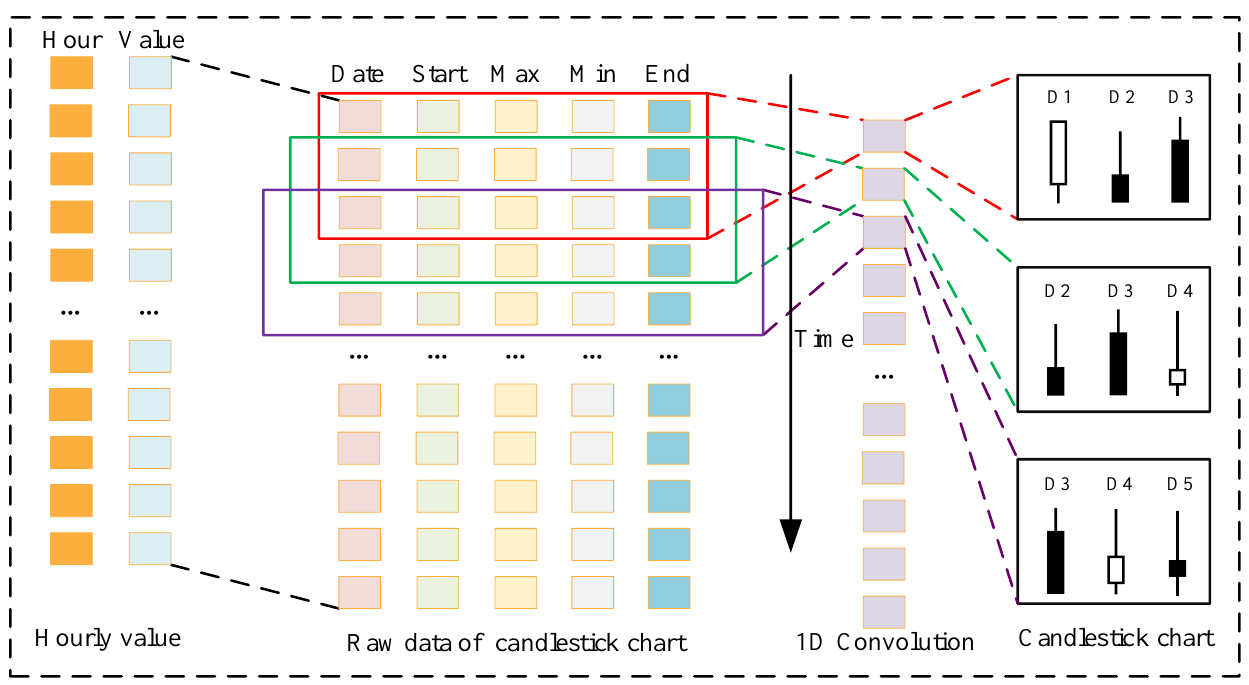
Figure 3. Principle of the candlestick chart generator. The VGG network model, proposed by the Oxford Visual Geometry Group, is adapted from the CNN mode, which can be widely used to extract image features and save key information [35]. The characteristics of the candlestick chart extracted by VGG are shown in Figure 4. The local features of water pollution were extracted by the convolutional layer, which corresponded to the pollution transfer process. The pollution on the first day would affect the pollution on the second and third days, and such features were extracted by the convolutional layer. The extracted feature was further strengthened by the pooling layer, where only strong features were retained and weak features were discarded, which improved the accuracy of the pollution process classification. The global classification information of water pollution was integrated by the fully connected layer, which was equivalent to the pollution process classifier [36].